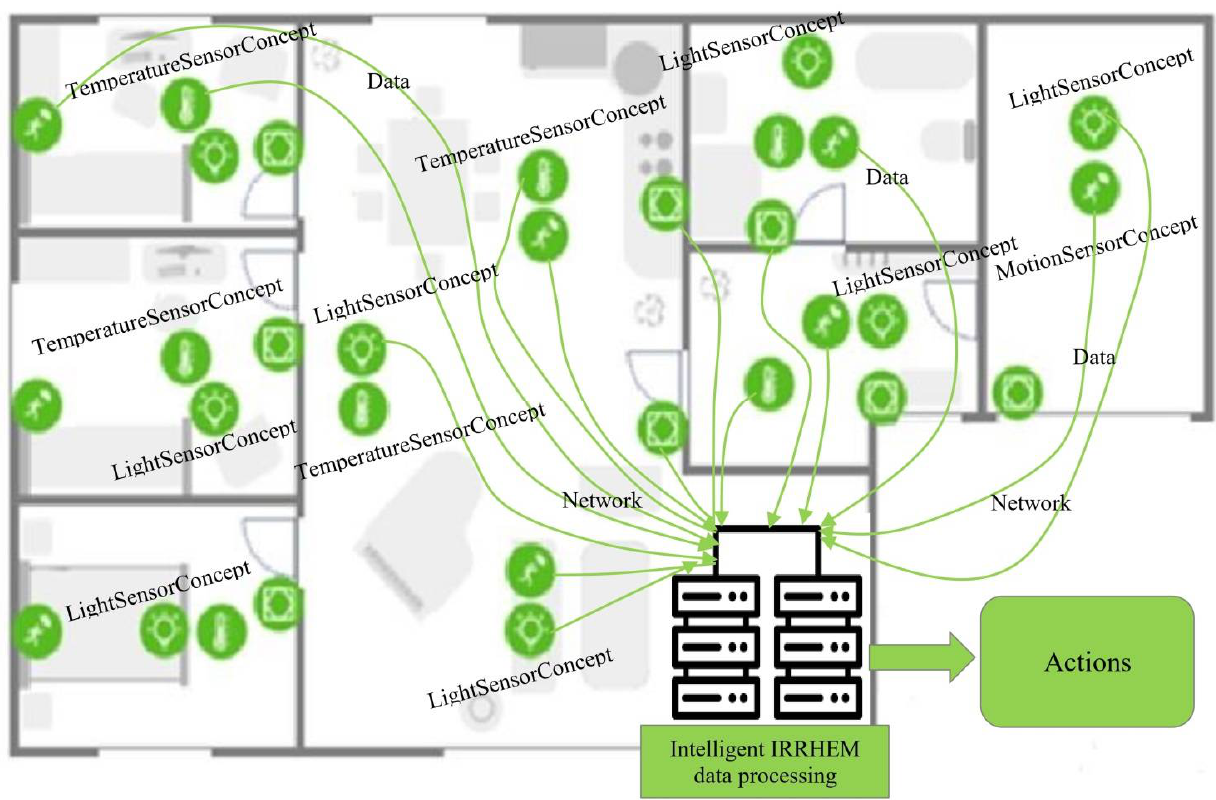
Figure 4. “Sensor” concept architecture in IRRHEM.